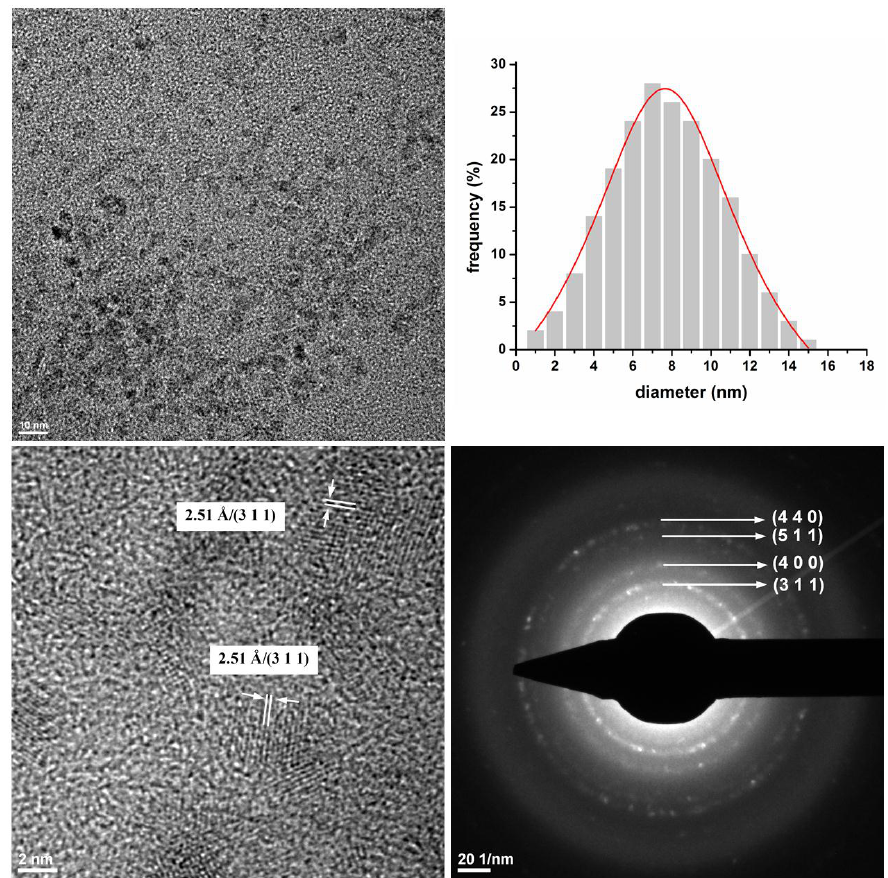
Figure 2. Large-area TEM ( top left ), size distributions ( top right ), HR-TEM images ( bottom left ) and selected area electron diffraction (SAED) ( bottom right ) of γ-Fe 2 O 3 coated with dextran.